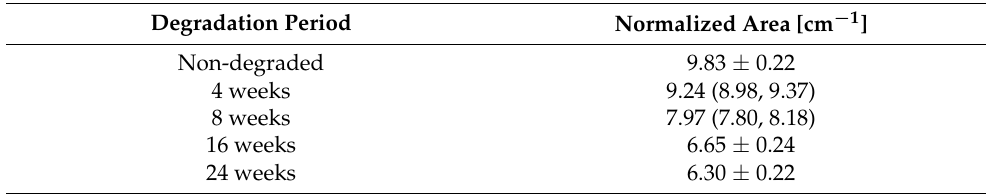
Table 3. The dependence of the area under the 1732 cm −1 peak shoulder (between 1736 and 1749 cm −1 ) on the degradation period.